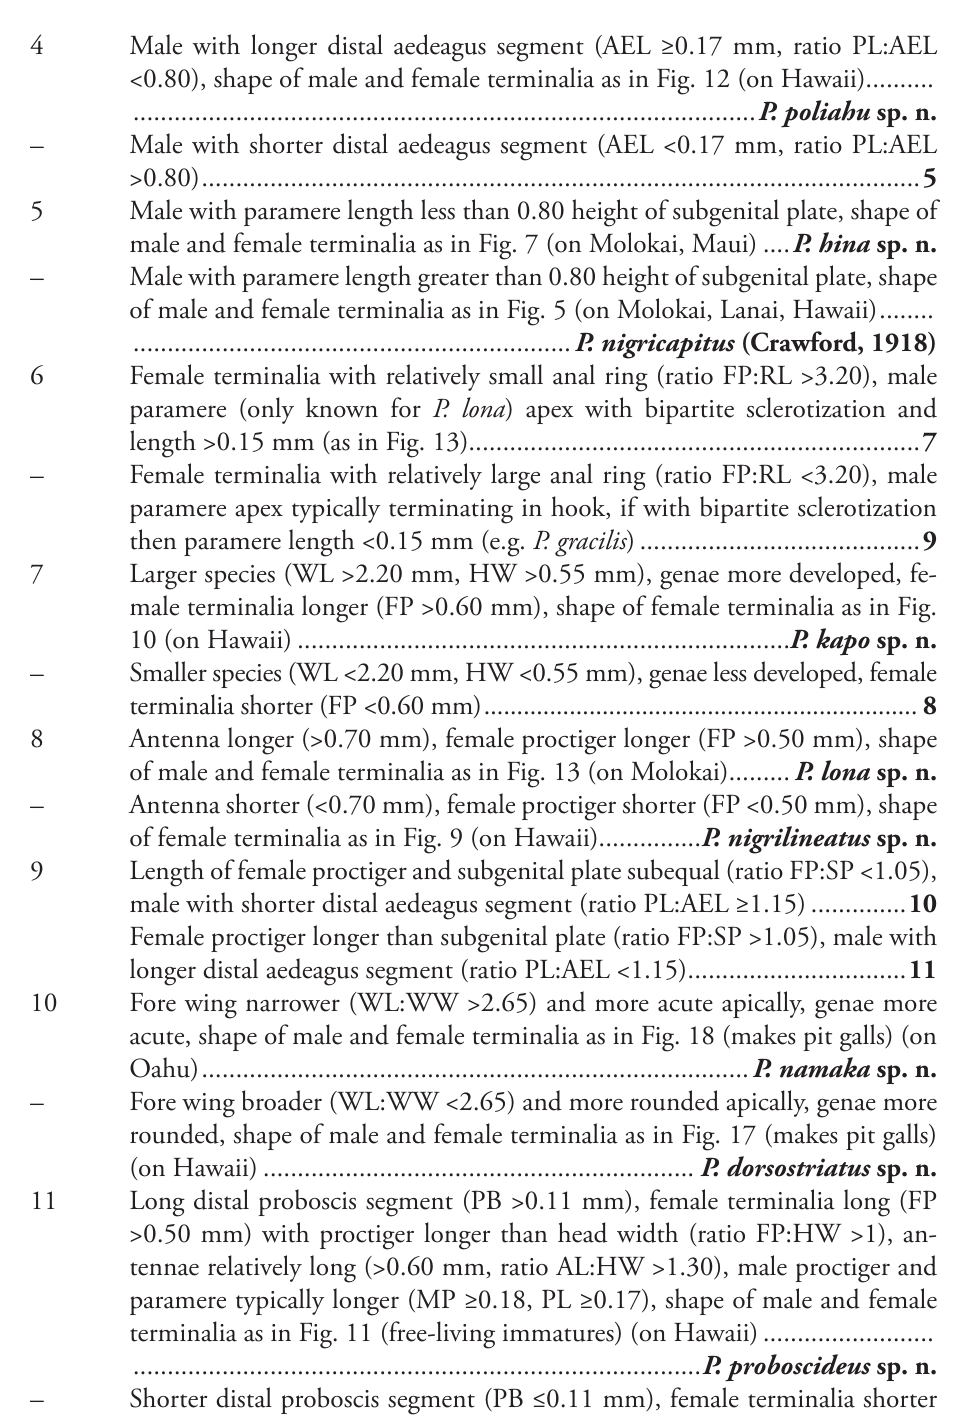
Male with longer distal aedeagus segment (AEL ≥0.17 mm, ratio PL:AEL <0.80), shape of male and female terminalia as in Fig. 12 (on Hawaii).......... ........................................................................................... P. poliahu sp. n. – Male with shorter distal aedeagus segment (AEL <0.17 mm, ratio PL:AEL >0.80) ......................................................................................................... 5 5 Male with paramere length less than 0.80 height of subgenital plate, shape of male and female terminalia as in Fig. 7 (on Molokai, Maui) .... P. hina sp. n. – Male with paramere length greater than 0.80 height of subgenital plate, shape of male and female terminalia as in Fig. 5 (on Molokai, Lanai, Hawaii) ........ ................................................................ P. nigricapitus (Crawford, 1918) 6 Female terminalia with relatively small anal ring (ratio FP:RL >3.20), male paramere (only known for P. lona ) apex with bipartite sclerotization and length >0.15 mm (as in Fig. 13).................................................................. 7 – Female terminalia with relatively large anal ring (ratio FP:RL <3.20), male paramere apex typically terminating in hook, if with bipartite sclerotization then paramere length <0.15 mm (e.g. P. gracilis ) ......................................... 9 7 Larger species (WL >2.20 mm, HW >0.55 mm), genae more developed, fe- male terminalia longer (FP >0.60 mm), shape of female terminalia as in Fig. 10 (on Hawaii) ........................................................................ P. kapo sp. n. – Smaller species (WL <2.20 mm, HW <0.55 mm), genae less developed, female terminalia shorter (FP <0.60 mm) .................................................................. 8 8 Antenna longer (>0.70 mm), female proctiger longer (FP >0.50 mm), shape of male and female terminalia as in Fig. 13 (on Molokai)......... P. lona sp. n. – Antenna shorter (<0.70 mm), female proctiger shorter (FP <0.50 mm), shape of female terminalia as in Fig. 9 (on Hawaii)............... P. nigrilineatus sp. n. 9 Length of female proctiger and subgenital plate subequal (ratio FP:SP <1.05), male with shorter distal aedeagus segment (ratio PL:AEL ≥1.15) .............. 10 Female proctiger longer than subgenital plate (ratio FP:SP >1.05), male with longer distal aedeagus segment (ratio PL:AEL <1.15) ................................ 11 10 Fore wing narrower (WL:WW >2.65) and more acute apically, genae more acute, shape of male and female terminalia as in Fig. 18 (makes pit galls) (on Oahu) ................................................................................ P. namaka sp. n. – Fore wing broader (WL:WW <2.65) and more rounded apically, genae more rounded, shape of male and female terminalia as in Fig. 17 (makes pit galls) (on Hawaii) ............................................................... P. dorsostriatus sp. n. 11 Long distal proboscis segment (PB >0.11 mm), female terminalia long (FP >0.50 mm) with proctiger longer than head width (ratio FP:HW >1), an- tennae relatively long (>0.60 mm, ratio AL:HW >1.30), male proctiger and paramere typically longer (MP ≥0.18, PL ≥0.17), shape of male and female terminalia as in Fig. 11 (free-living immatures) (on Hawaii) ......................... ................................................................................... P. proboscideus sp. n. – Shorter distal proboscis segment (PB ≤0.11 mm), female terminalia shorter (FP <0.50 mm) with proctiger shorter than head width (ratio FP:HW